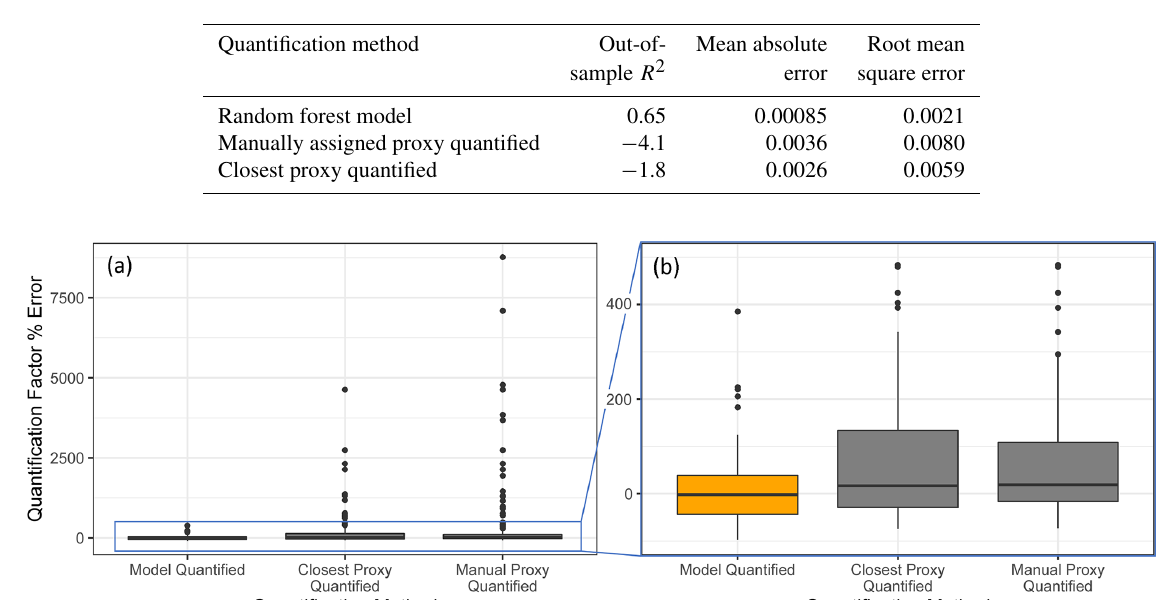
Table 5. Performance metrics for quantification factor prediction for three methods of unidentified compound quantification, i.e., random forest modeling, manually assigned proxy quantified, and closest proxy quantified.